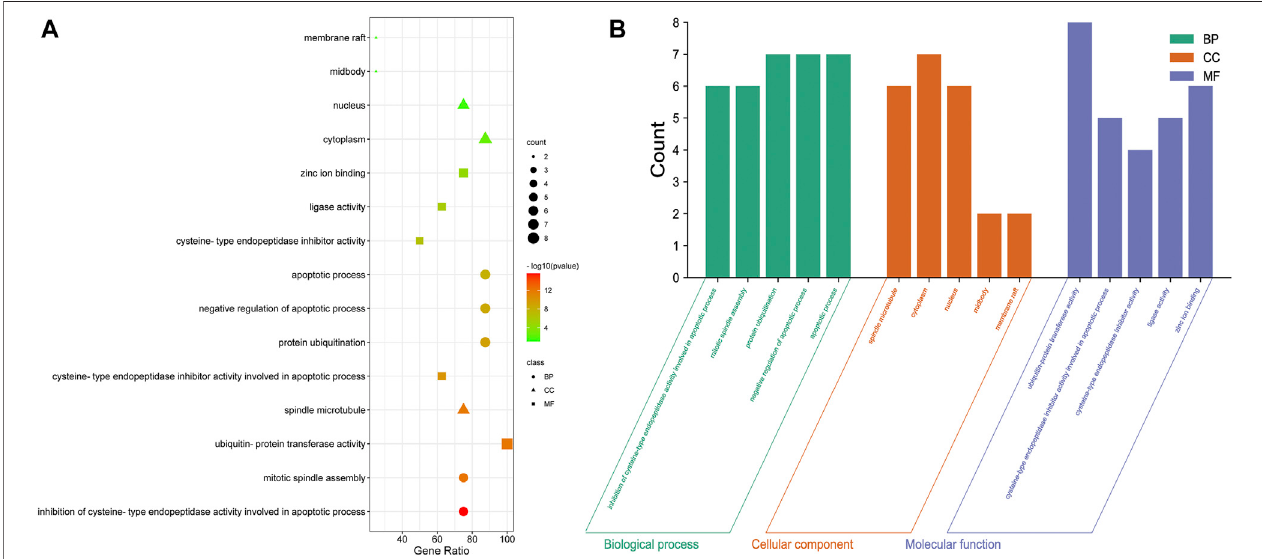
FIGURE 6 | GO analysis of IAPs. (A) Enrichment dot bubble diagram. (B) Enrichment histogram. GO, Gene Ontology; BP, biological processes; CC, cellular components; MF, molecular functions.